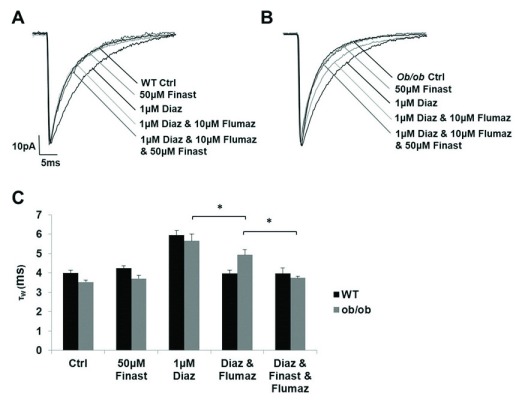
Prolonged exposure (2 hrs) of mature cortical neurones to diazepam (1 μM) in the presence of flumazenil had an exaggerated effect on the cortical GABA
AR-mediated mIPSCs of
ob/ob mice in comparison to WT mice.(
A) Superimposed exemplar averaged GABA
AR-mediated miniature inhibitory postsynaptic currents (mIPSCs) acquired from a representative WT cortical neurone and from equivalent neurones after ~2 hours pre-incubation of the brain slice with diazepam (1 μM), flumazenil (10 μM) and finasteride (50 μM). (
B) Superimposed exemplar averaged GABA
AR-mediated mIPSCs acquired from a representative
ob/ob cortical neurone and from equivalent neurones after ~2 hours pre-incubation of the brain slice with diazepam (1μM), flumazenil (10 μM) and finasteride (50 μM). (
C) Histogram illustrating that flumazenil is able to prevent the effect of diazepam to prolong the duration of the GABA
AR-mediated mIPSC in WT cortical neurones, but only has a partial efficacy in
ob/ob cortical neurones (τ
w in ms; one-way ANOVA,
P >0.05;
Post hoc Newman Keul’s test). The persisting effect of diazepam in the presence of flumazenil in the
ob/ob mice could be prevented by the presence of the 5α-reductase enzyme inhibitor finasteride (τ
w in ms; one-way ANOVA,
P >0.05;
Post hoc Newman Keul’s test). Ctrl = control; Finast = finasteride; Diaz = diazepam; Flumaz = flumazenil.